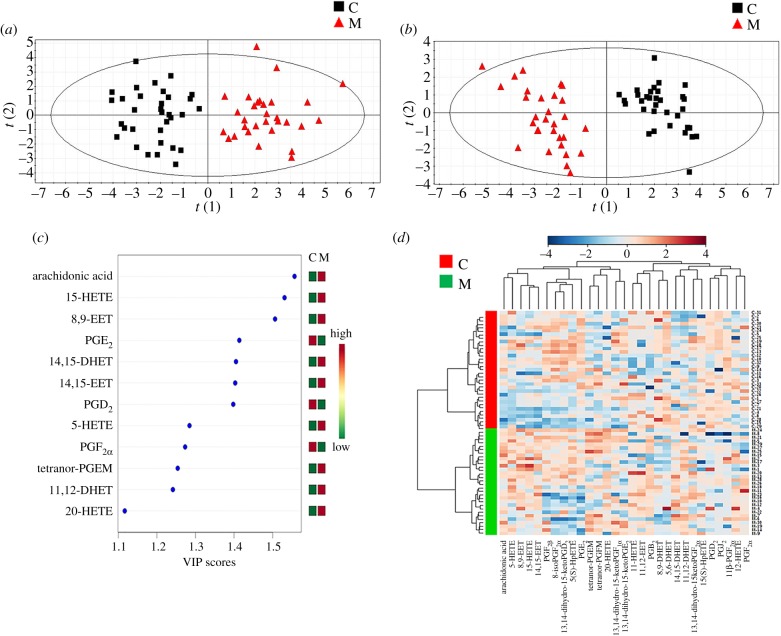
Metabolic profiling of AA metabolic alterations in asthenozoospermia patients. (a) PCA score plot of healthy and asthenozoospermic group (square, healthy group; triangle, asthenozoospermic group). (b) PLS-DA score plot of healthy and asthenozoospermic group (square, healthy group; triangle, asthenozoospermic group). (c) Top 12 significantly changed metabolites based on VIP scores of PLS-DA. (d) Heatmap of hierarchical clustering based on differential metabolites of importance for healthy and asthenozoospermic seminal plasma. (C refers to healthy group, M refers to asthenozoospermic group. Rows: samples; columns: differential metabolites; colour key indicates metabolite expression value, blue: low concentration, red: high concentration.)